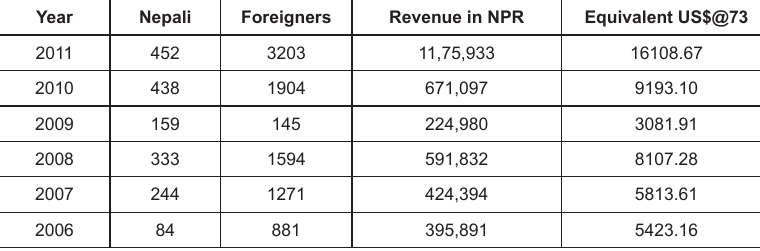
Table 6. Flow of visitors and revenue collection in KTWR from 2006-2011